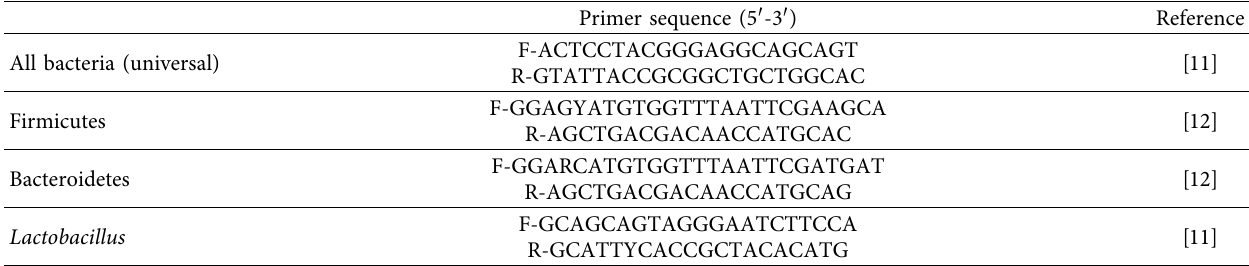
Table 1: Primer sets used for amplification